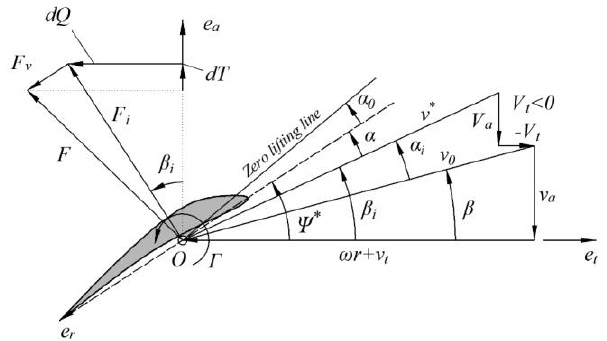
Figure 24. The force and velocity triangle at the control point on the lifting line.